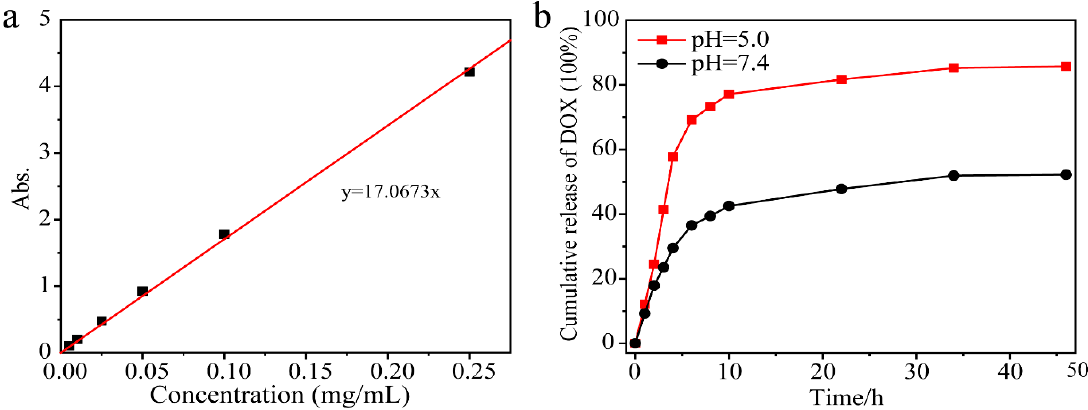
Figure 7. ( a ) Standard curve of DOX concentration and absorption, ( b ) drug release profiles